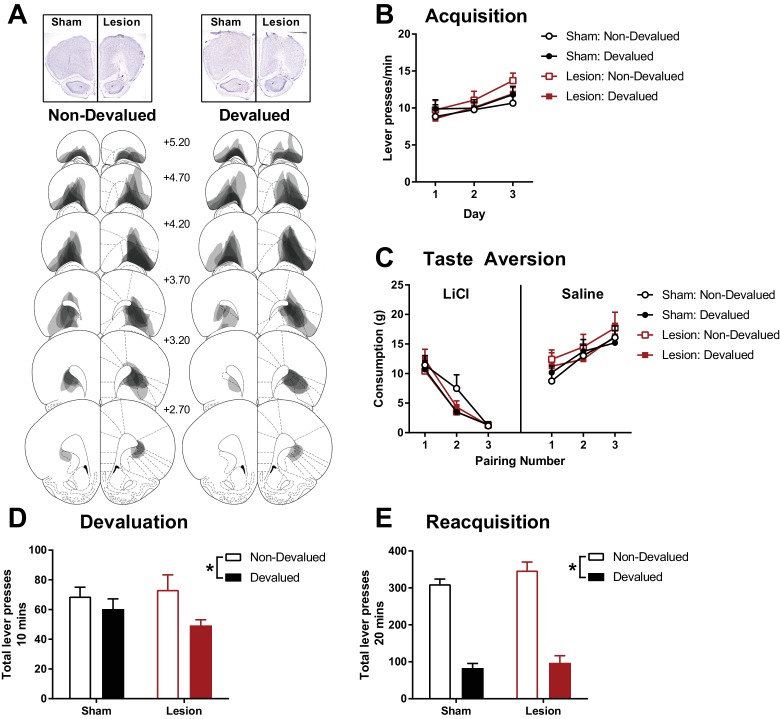
The effects of excitotoxic OFC lesions on instrumental devaluation by taste aversion.(A) Representative OFC lesion damage in the Non-Devalued (left) and Devalued (right) lesion groups. Semi-transparent grey patches represent lesion damage in a single subject, and darker areas represent overlapping damage across multiple subjects. Coronal sections are identified in mm relative to bregma (Paxinos and Watson, 1997). (B) Rate of lever pressing during 3 days of instrumental acquisition. (C) Mean reward consumption during taste aversion learning, consumption of rewards paired with LiCl induced nausea decreased across injection pairings (Left), whereas consumption of rewards paired with saline injections increased across injection pairings. (D) Total lever presses during the 10 mins devaluation test in extinction. Within-session responding presented in Figure 1—figure supplement 1. (E) Total lever presses during the 20 mins re-acquisition test with rewards delivered instrumentally. Error bars depict + SEM. (*) Symbol denotes statistical significance of simple or main effects following a significant interaction.